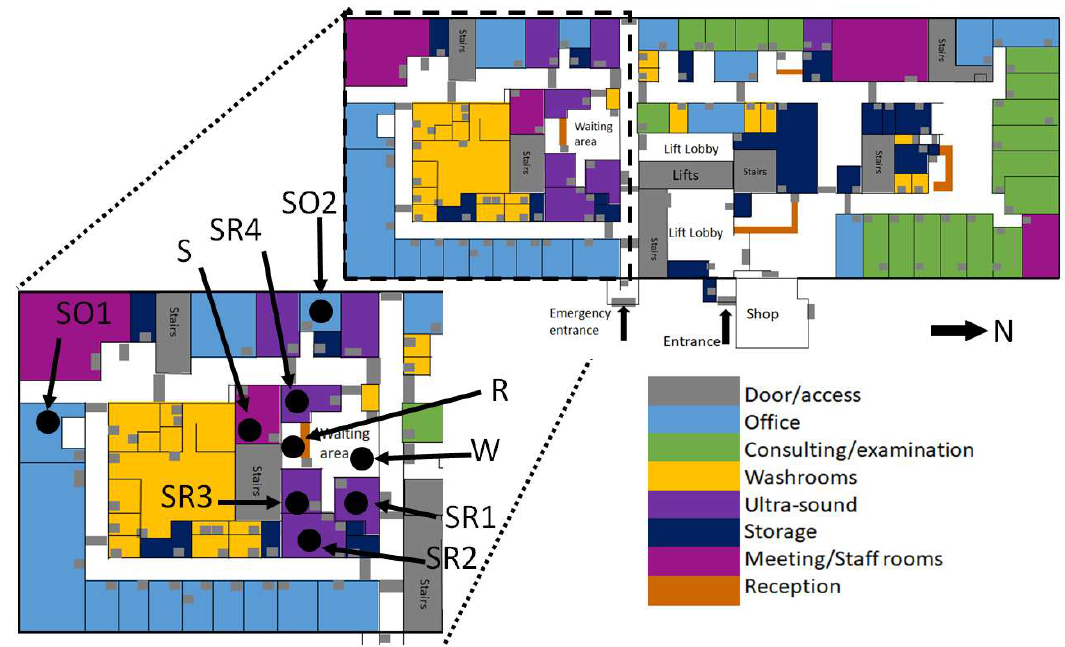
Figure 2. Floor plan of level 2 of the Maternity and Gynaecology building, colour coded by room use. Total area: 2162.52 m 2 . Cutaway shows the focus area of the study and the symbols for sensors and locations are described in Table 1. The map is based on building plans provided by RBH. Table 1. Symbols used for sensors, room size and location within the test area. Locations are shown in Figure